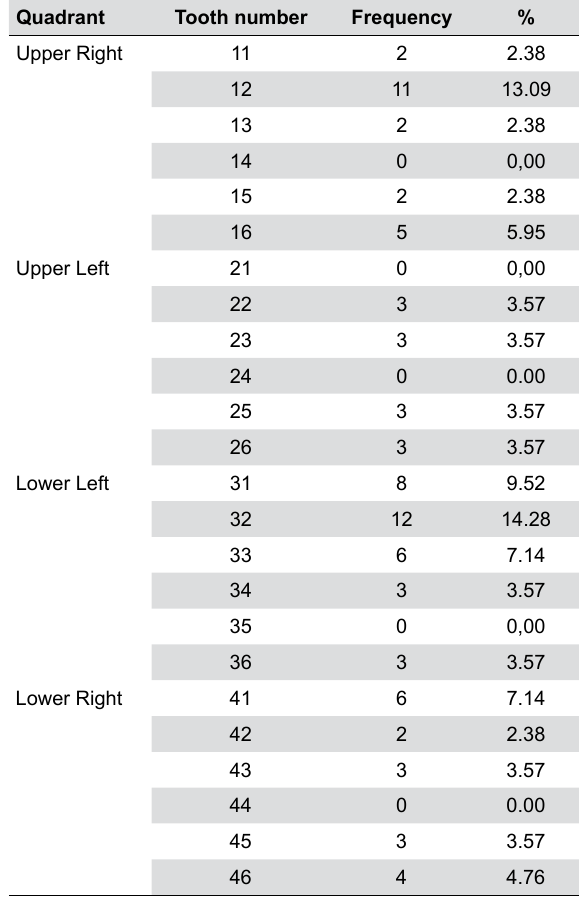
Table 2- Frequencies and percentages of quadrants in which the highest pain or no pain was perceived